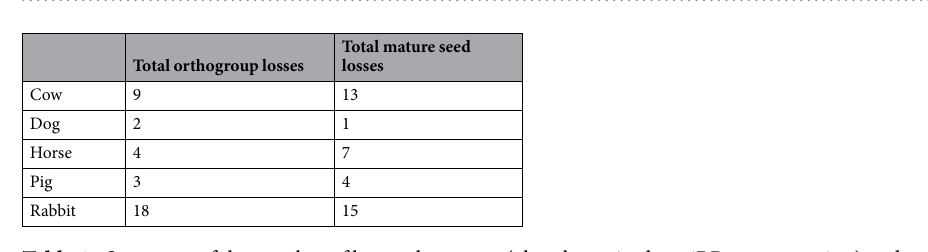
Table 4. Summary of the number of lost orthogroups (also absent in the miRBase annotation) and seed